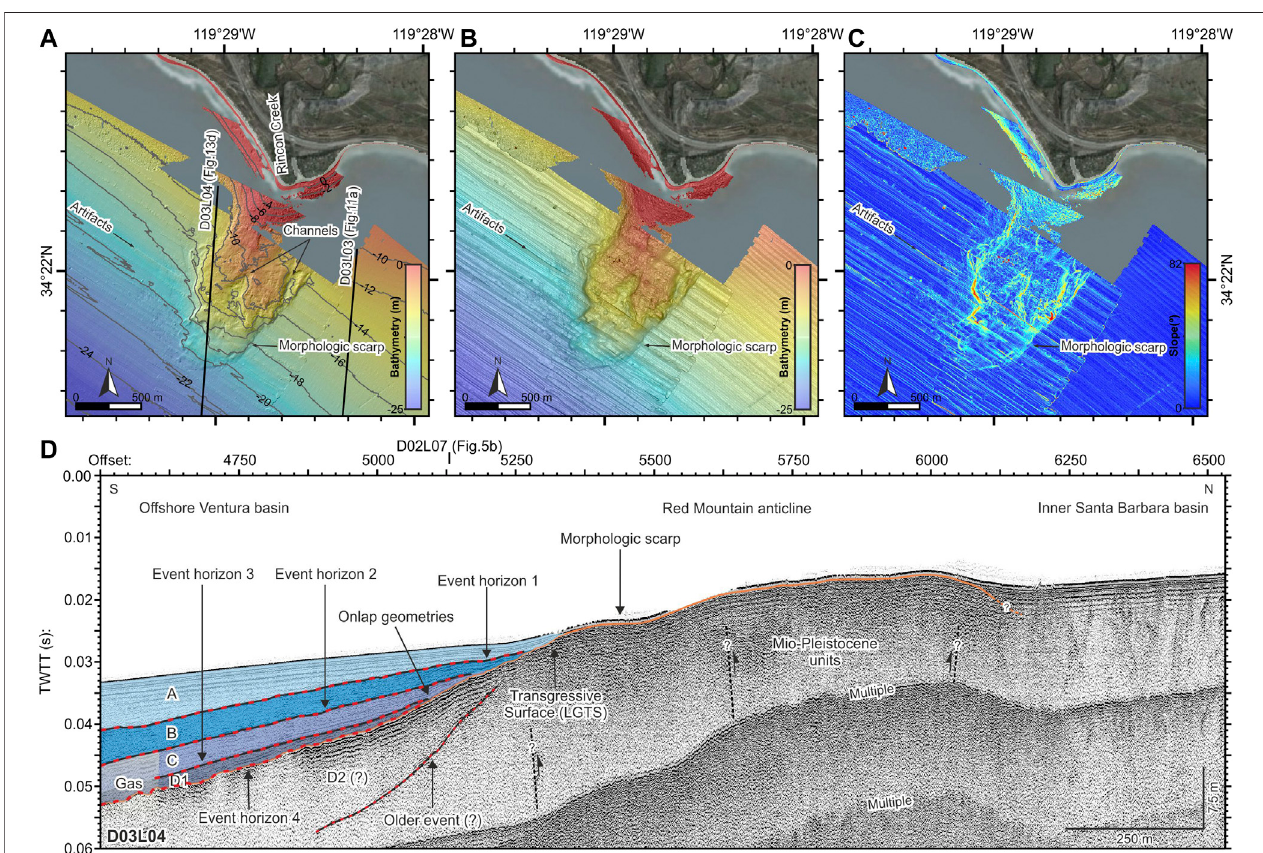
FIGURE13| High-resolution(2 m;Johnsonetal.,2017a)bathymetric-hillshade (A) ,bathymetric-slope-enhancedrelief (B) andslope (C) mapsoftheoffshorearea south of Rincon Point showing different morphological features on the observed SSW-NNE elongated ridge. CHIRP dip pro fi le D03L03 in (A) corresponds to the zone between offsets 4250 and 5700 m in Figure 11A and images the deformed LGTS across the Red Mountain anticline. (D) Interpreted CHIRP dip pro fi le D03L04 shows the folding of the Last Glacial transgressive surface (LGTS; continuous orange line) related to the offshore Red Mountain anticline. Note the thick onlapping HoloceneunitsontotheRedMountainanticlineandthedifferenteventsofdeformation(i.e.,inferredearthquakes;reddashedlines).Thelocationofthepro fi leisshownin Figures 2 , 3 , 13A . Uninterpreted pro fi le is provided in Supplementary Figure S11 .